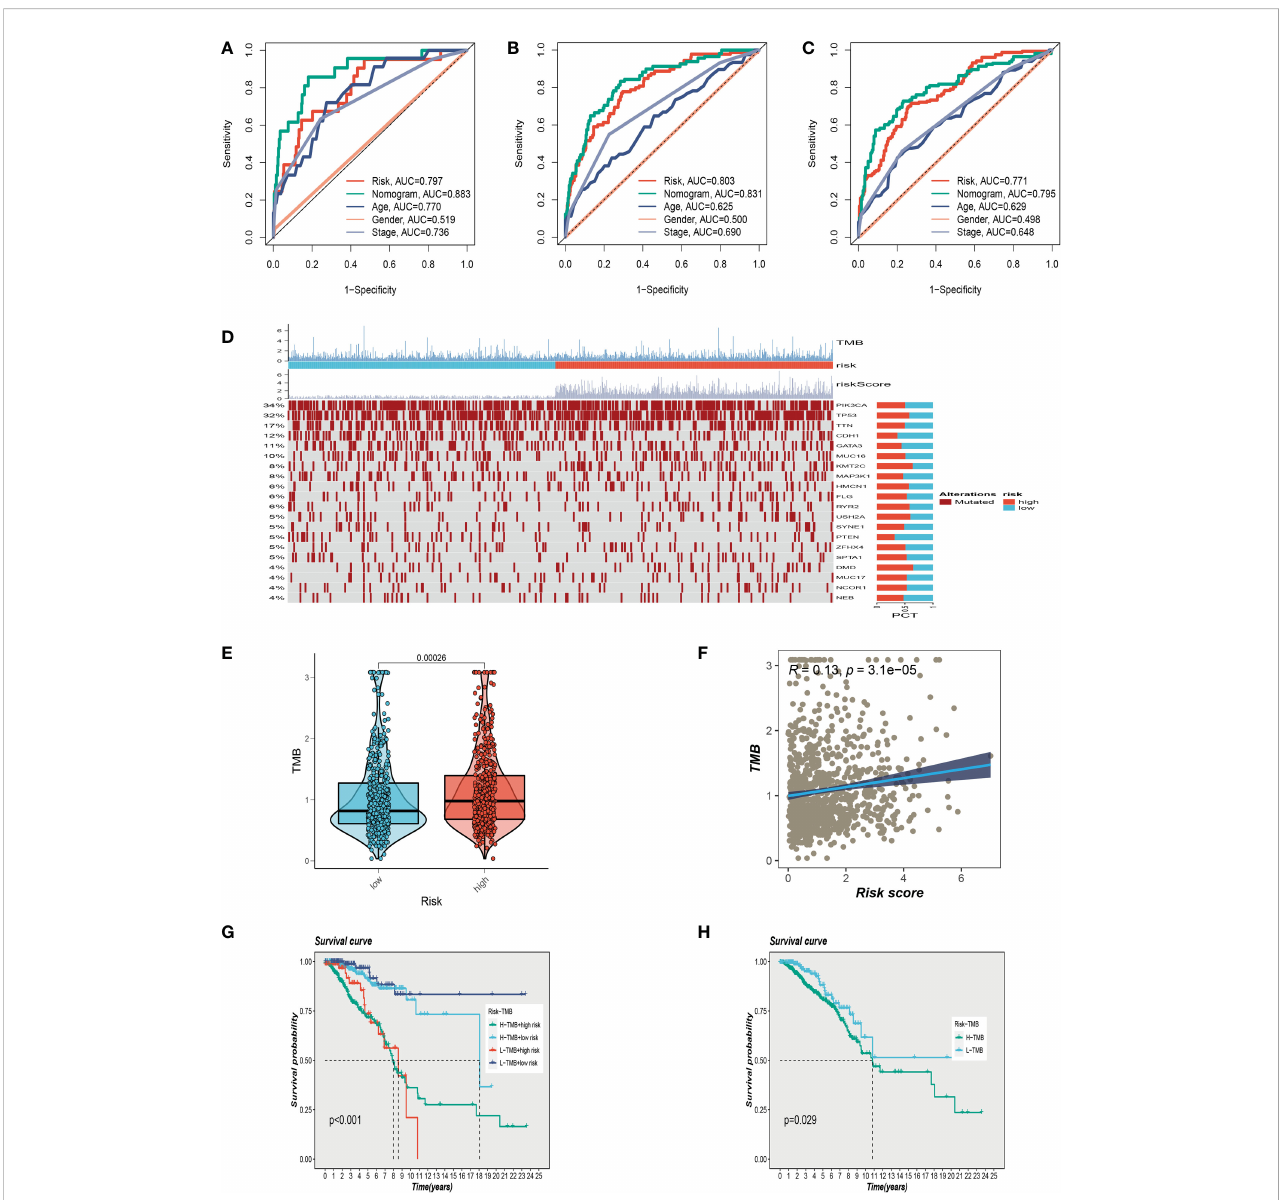
FIGURE 5 Clinical correlation analysis and gene mutation analysis. (A – C) Prognostic ROC analysis in 1, 3, and 5 years, respectively. (D) The representative gene variants in the groups at high and low-risk groups. (E) The two risk groups have differences in tumor mutation burden (TMB) levels. (F) The correlation between TMB and risk score. (G, H) Correlation analysis between TMB and